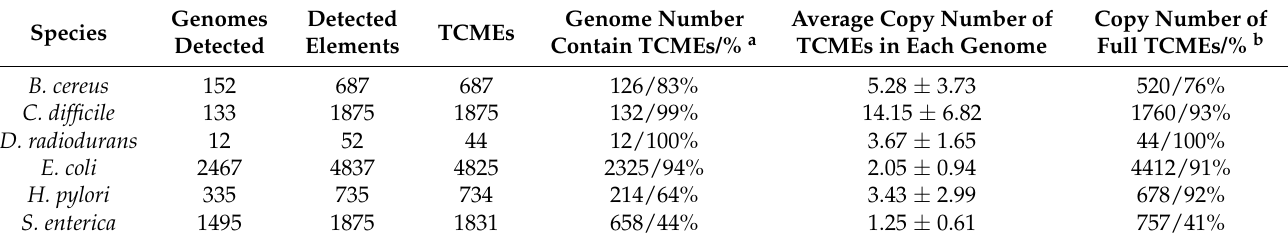
Table 1. Distribution of TnpB-containing mobile elements (TCMEs) in six